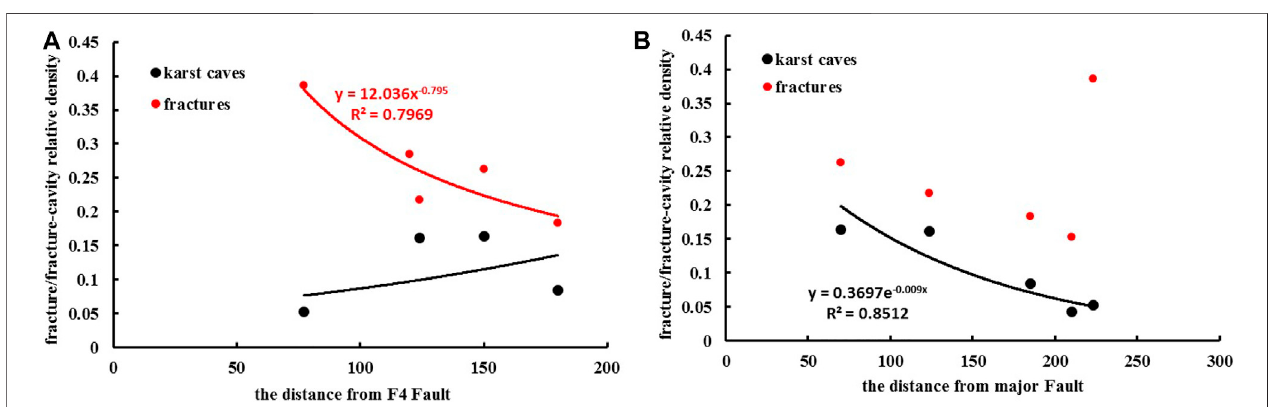
FIGURE 13 | (A) Relationship between fracture – cavity density and distance from the F4 secondary fault. (B) Relationship between fracture – cavity density and distance from the major fault.